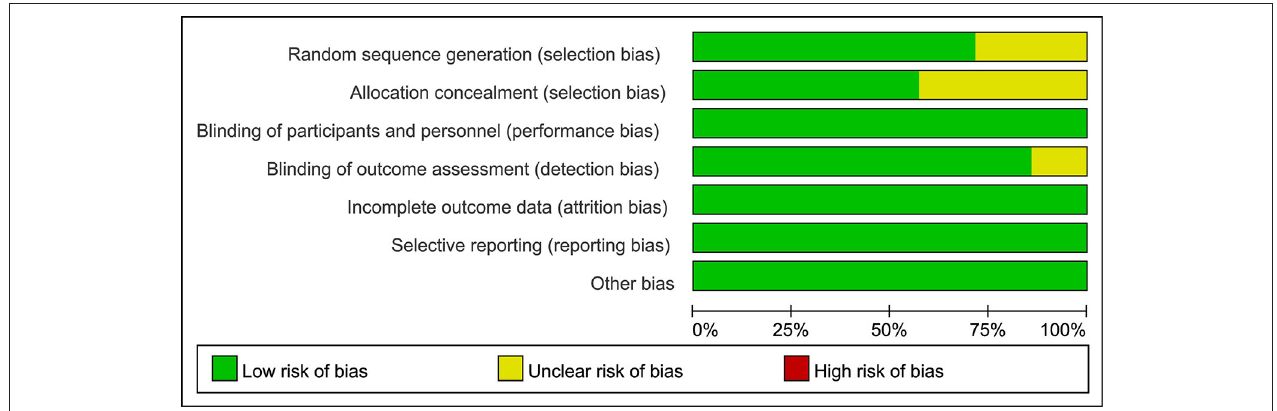
FIGURE 3 | Risk of bias summary: review authors judgements about each risk of bias item for each included